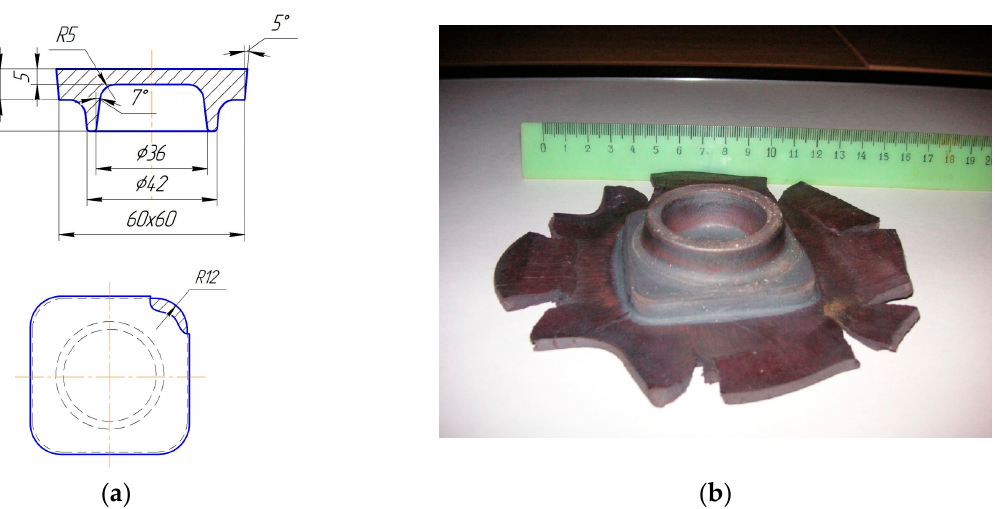
Figure 3. Sketch ( a ) and photo ( b ) of the flange forging. Microstructural analysis was carried out on samples, the cutting scheme of which, from the fourth part of the flange’s forging, is shown in Figure 4a. The measurement of the size and shape of graphite grains was carried out on layer-by-layer and end-face sections of the samples. Zones of the microstructural studies were selected on the planes of layered samples, in which the values of deformation and stress in the intensity indicator were determined using mathematical modeling. For samples № 1, № 3, and № 7, they are given in Tables 2 and 3.